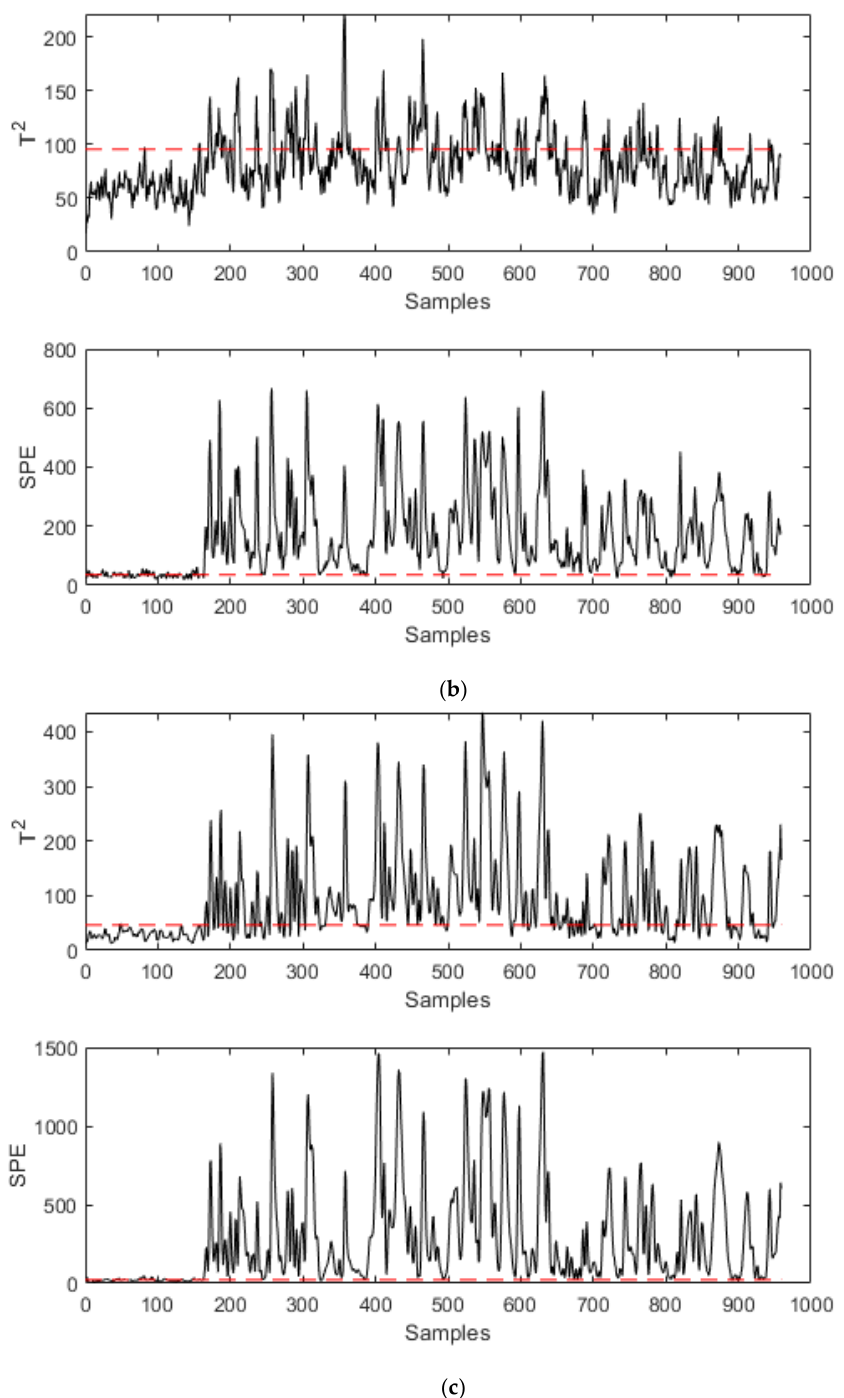
Figure 9. ( a ) Monitoring results of PCA in fault 11. ( b ) Monitoring results of DPCA in fault 11. ( c ) Monitoring results of GA-DPCA in fault 11.